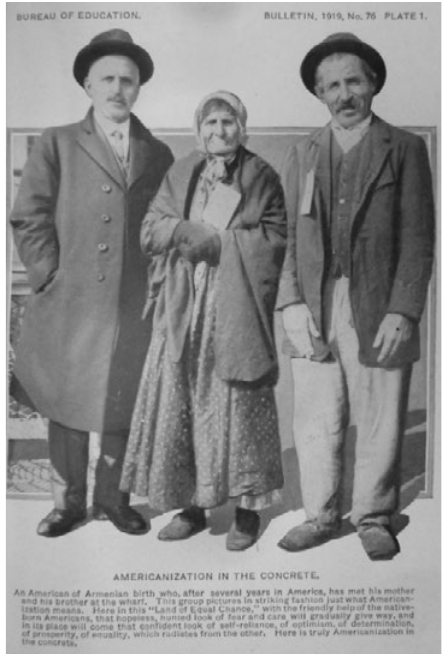
Figure 1 Source: Butler, Community Americanization , plate